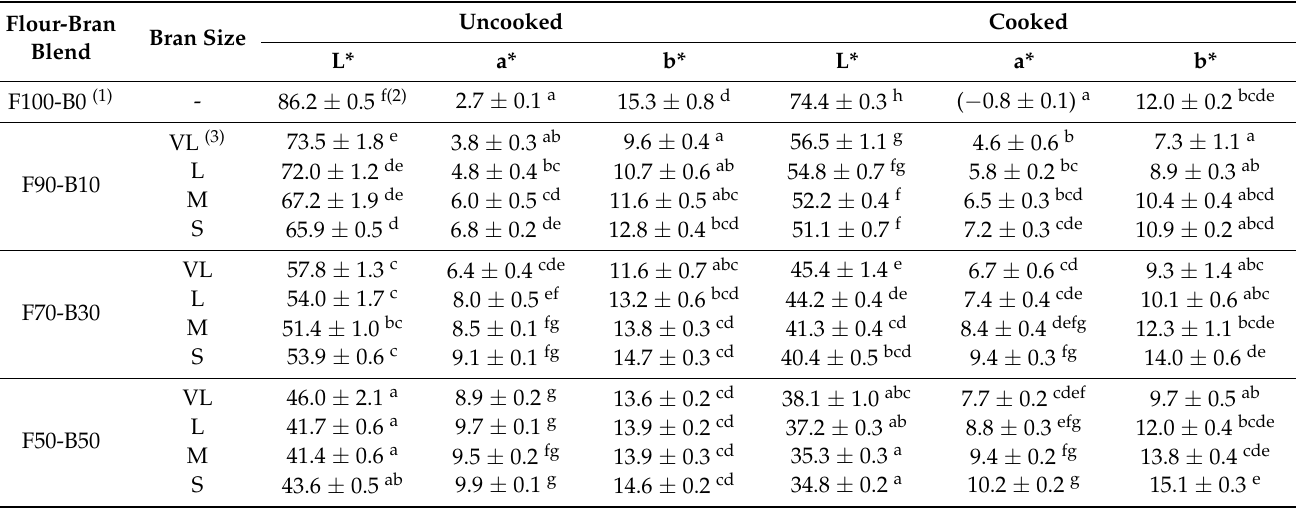
Table 5. Color of fresh noodle sheets and cooked noodles prepared from flour-bran blends with different bran sizes and blend